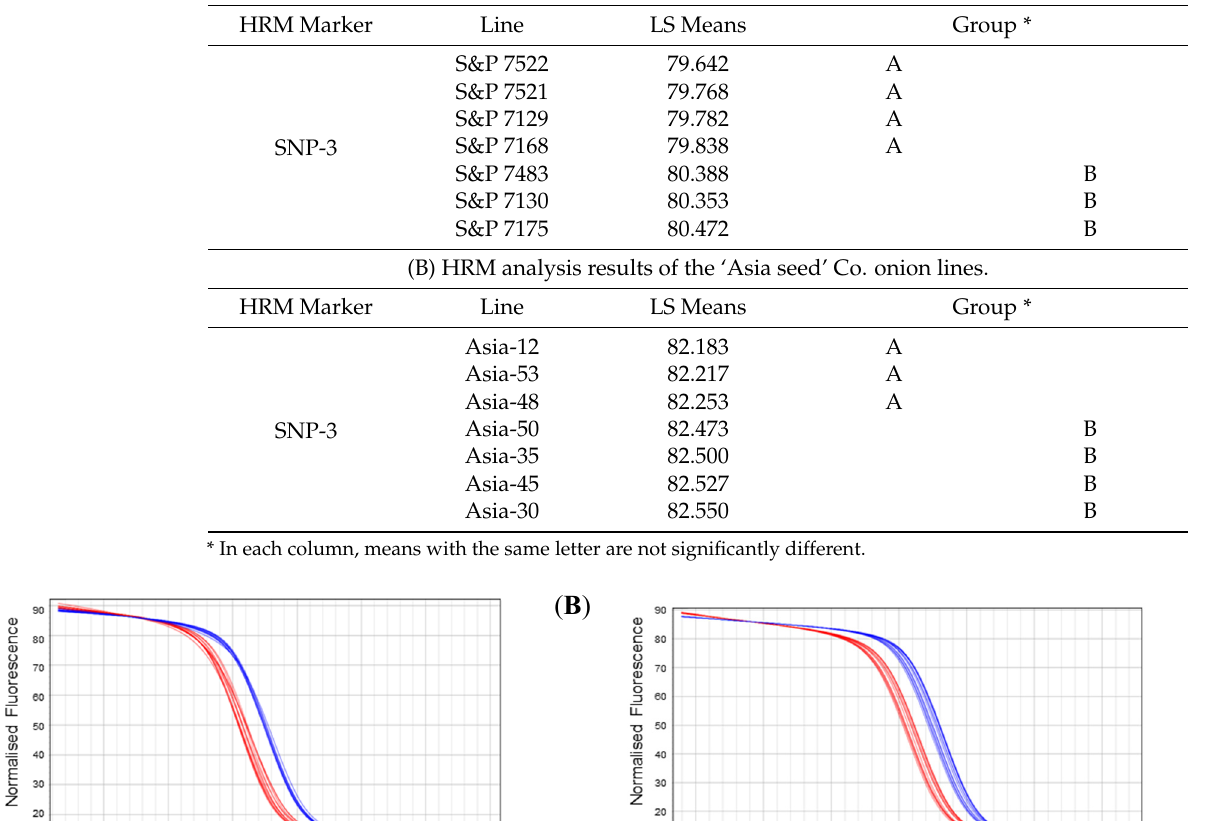
Table 3. HRM analysis with the SNP-3 primers and statistically grouped by using ANOVA. (A) HRM analysis results of the ‘Seeds & People’ Co. onion lines.